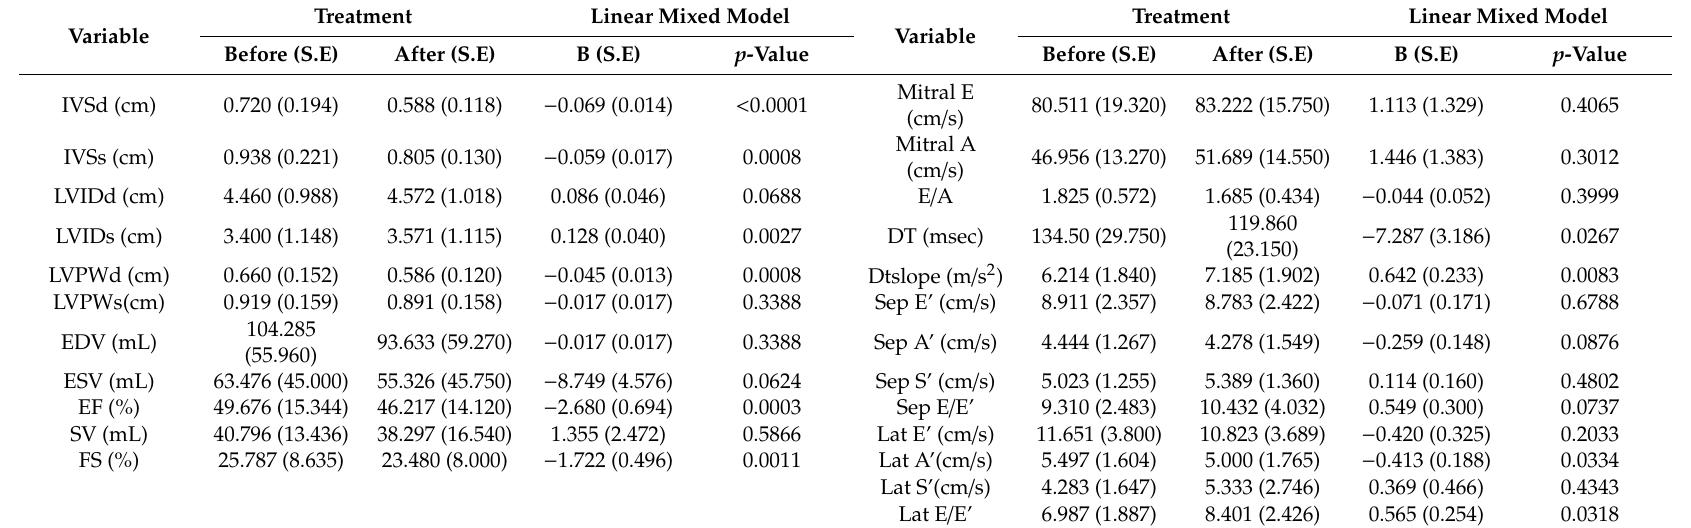
Table 2. The change values of echocardiographic data over time and the mean values of echocardiography before and after